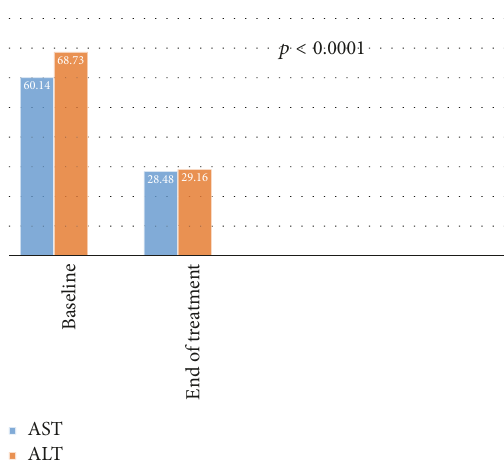
Figure 3: Outcome of serum transaminase level before and after DAA therapy (two-sample 𝑡 -test; 𝑝 < 0.0001